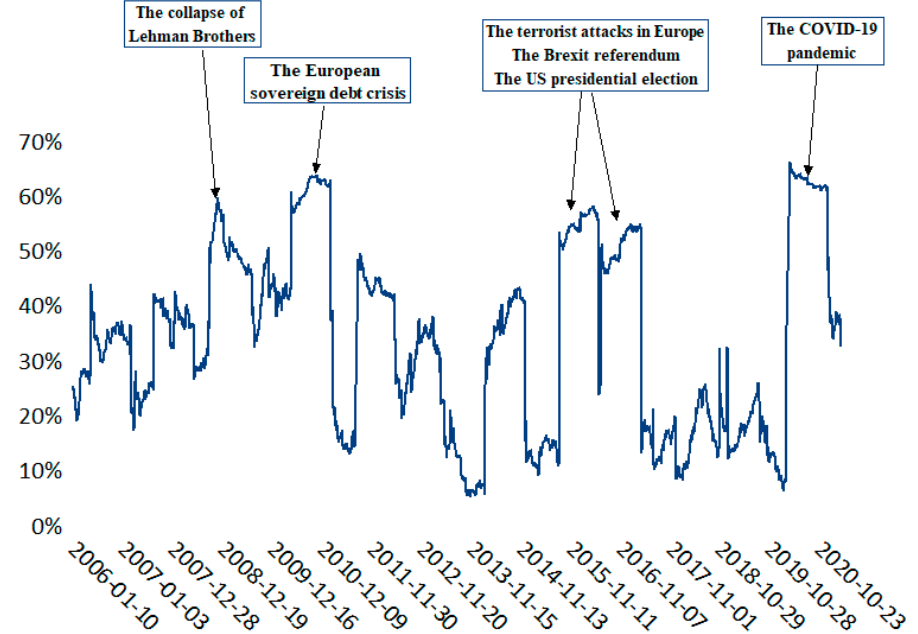
Figure 5. Rolling window estimation of total spillover index.